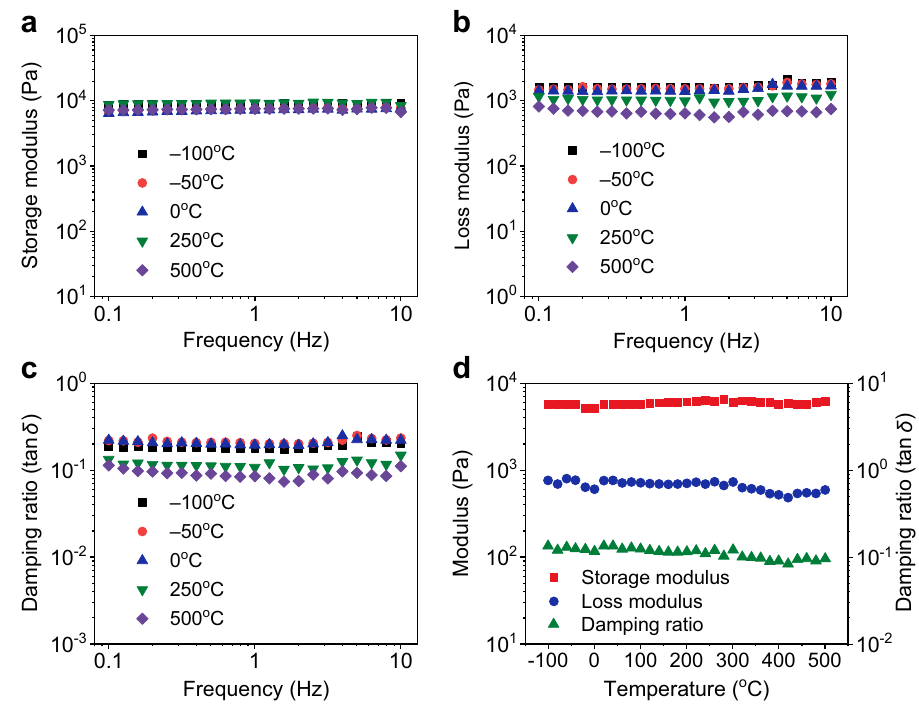
Fig. 3 Mechanical properties of the FCNSs over a wide range of temperatures. a – c Storage modulus, loss modulus, and damping ratio of the FCNS70 versus frequency (0.1 – 10 Hz) at temperatures from − 100 to 500 °C. d The temperature dependence of the storage modulus, loss modulus, and damping ratio for